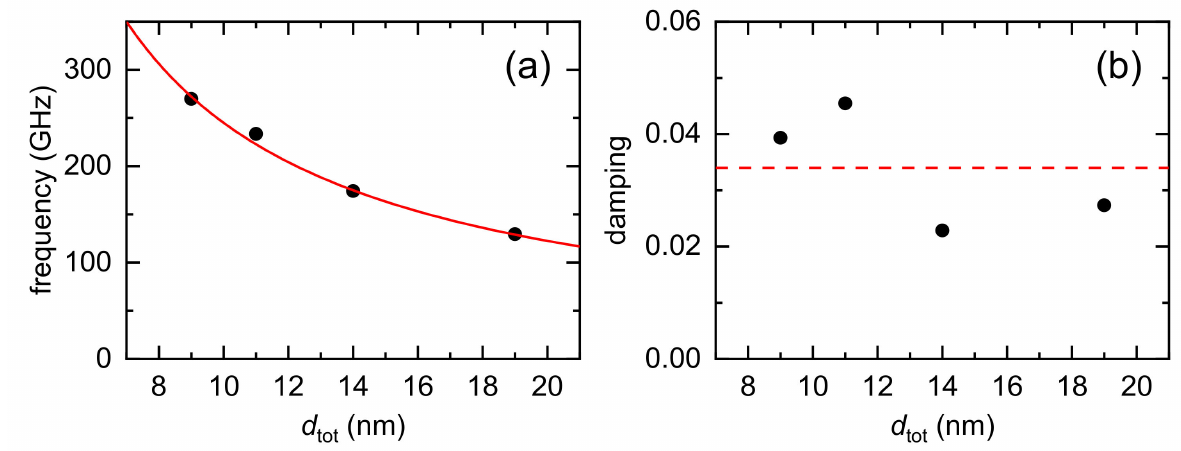
Figure 5. Frequency and damping of acoustic oscillation. ( a ) The frequency of the acoustic oscillation of the sap/Co 50 B 50 (5, 7, 10, and 15 nm)/Pt (4 nm) samples. The d tot represents the total thickness of Co 50 B 50 and Pt. The red line is the fitting with f = v s , where v s is 4900 m s − 1 . ( b ) The damping ( α ) of acoustic oscillations of the sap/Co 50 B 50 (5, 7, 10, and 2 d tot 15 nm)/Pt (4 nm) samples. The red dotted line indicates an α of